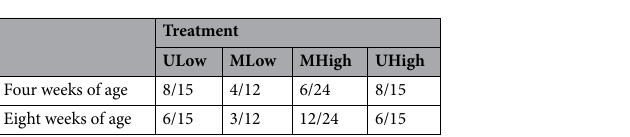
Table 1. Ratio of calves with a health score of 1 by treatment and age